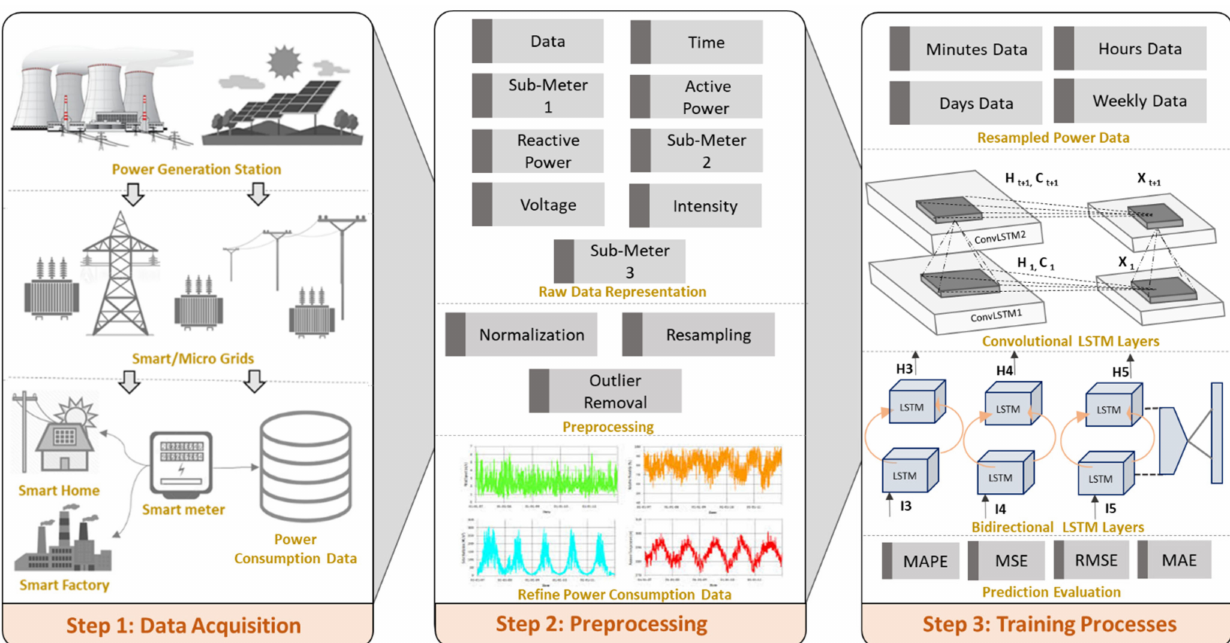
Figure 1. The proposed framework for power energy consumption prediction comprises three main steps—Step 1: the smart microgrids generate power energy and supply it to residential buildings/smart factories where smart meters measure the consumed energy; Step 2: smart meters’ data are significantly influenced by environmental factors that generate abnormalities; therefore, data cleansing schemes are applied as preprocessing step; and Step 3: train the model with refined data in which ConvLSTM and BiLSTM layers are used for encoding and decoding the numerous resolutions of data to obtain a minimum error rate.